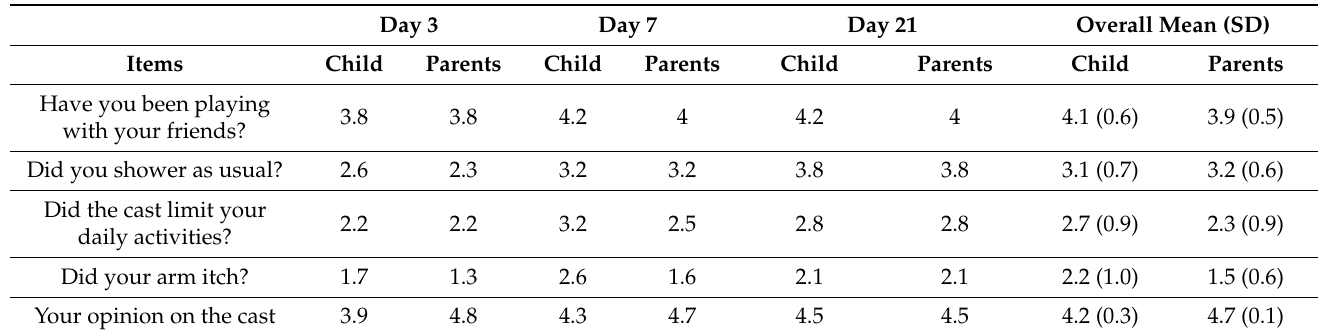
Table 3. General comfort questionnaire: scores are reported as means at each follow-up visit and as overall mean with SD.